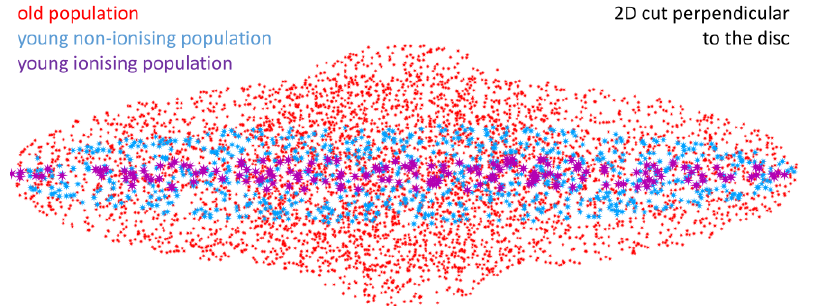
Figure 1. A schematic of the standard geometric model of spiral galaxies adopted in our studies. The model consists of an old stellar bulge and disk component, and two young stellar populations: a non-ionising (100 Myr), and an ionising (10 Myr). The dust distribution is assumed to have the same scale-height as the young non-ionising stars. Image Credit: